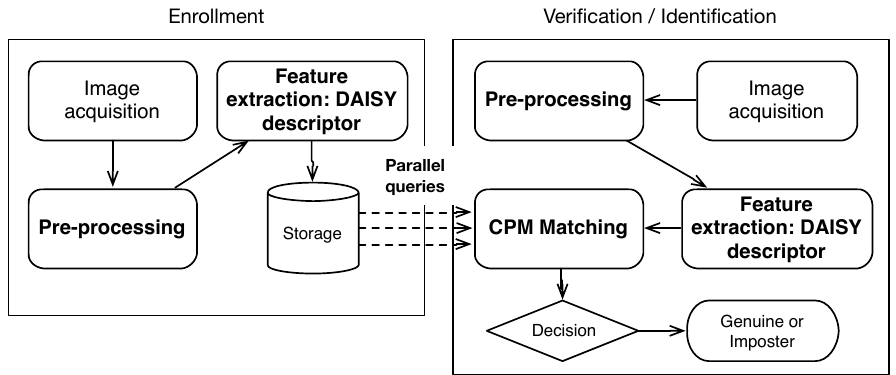
Figure 4. Flowchart of our approach for palm vein recognition based on deformation information. The modifications and/or contributions with respect to [45] are highlighted in bold